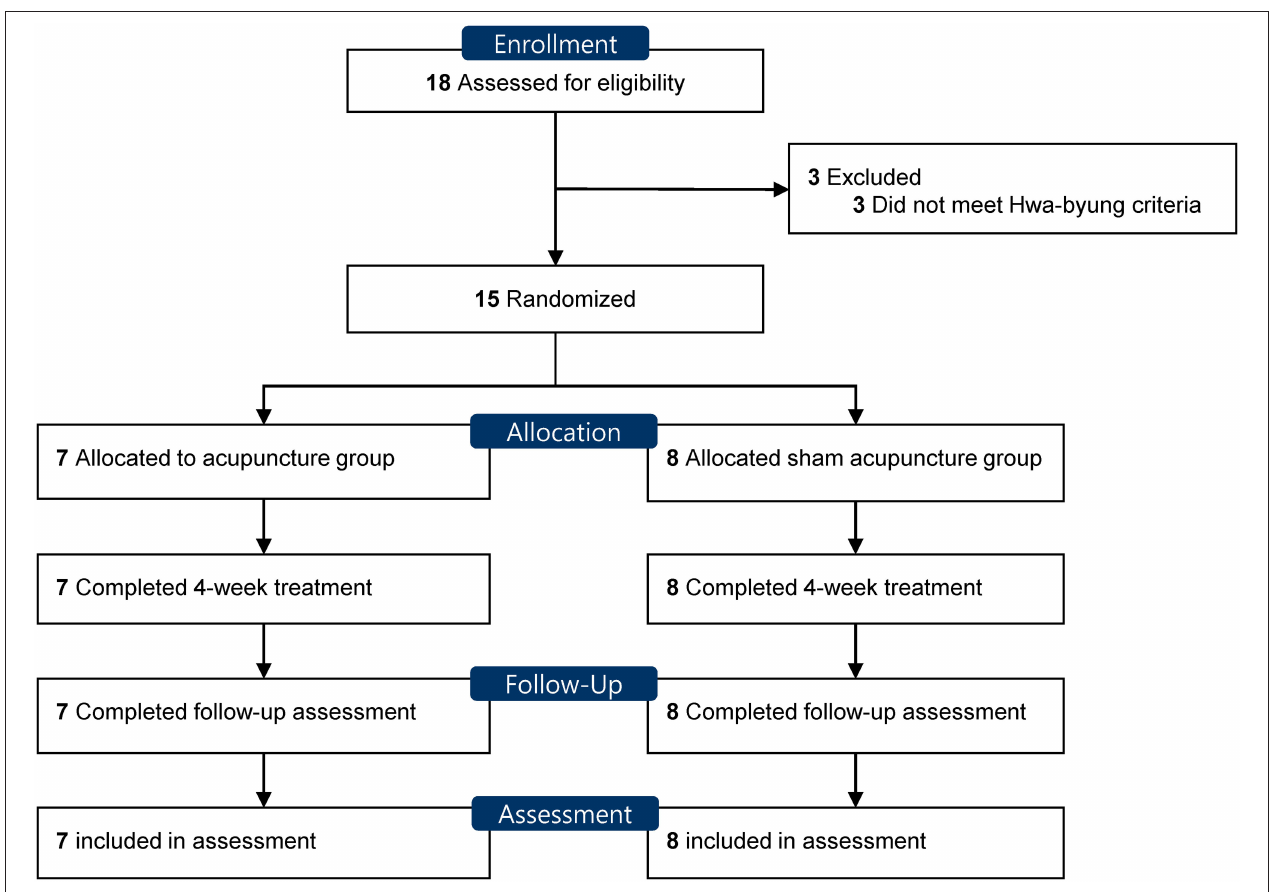
FIGURE 1 | Flow diagram of participants in the feasibility